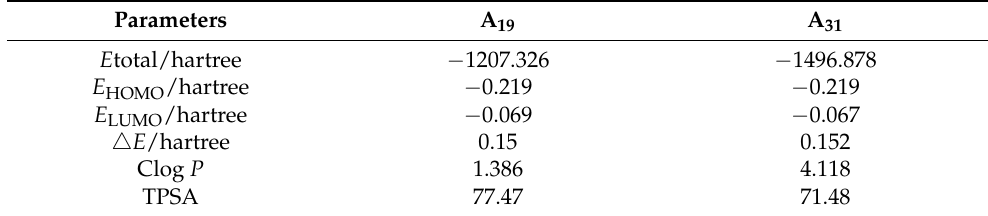
Table 4. The total energy, HOMO, LUMO, energy gap, C Log P, and TPSA of A 19 and A 31